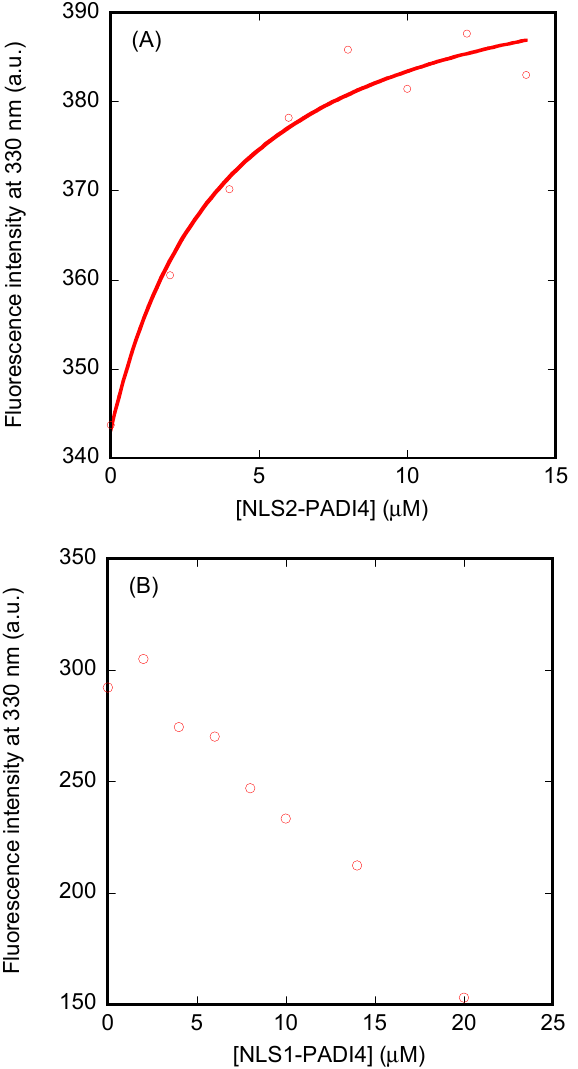
Figure 9. Binding of importin species to NLS1- and NLS2-PADI4 as monitored by fluorescence: ( A ) Titration curve monitoring the changes of fluorescence at 330 nm when NLS2-PADI4 was added to Δ Imp α 3. The fluorescence intensity on the y -axis is the relative fluorescence intensity after removal of the corresponding blank. The line through the data is fitted to Equation (2). ( B ) Titration curve monitoring the changes in the fluorescence at 330 nm when NLS1-PADI4 was added to Imp α 3. The fluorescence intensity on the y -axis is the relative fluorescence intensity after removal of the corresponding blank. All experiments were carried out at 25 °C.